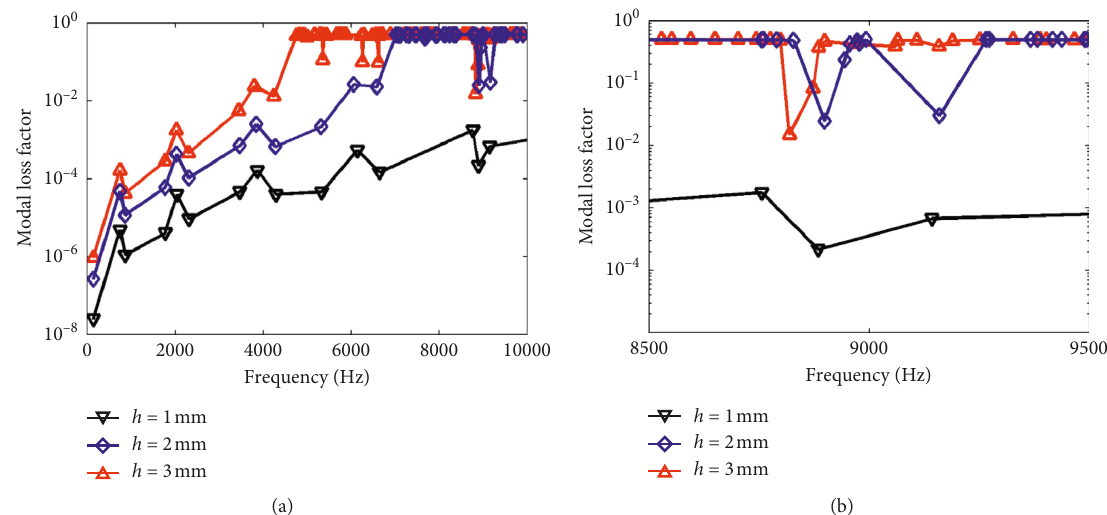
Figure 11: Modal loss factor of ABH beams with different damping layer thickness: (a) calculation frequency from 0 to 10kHz; (b) calculation frequency from 8500 to